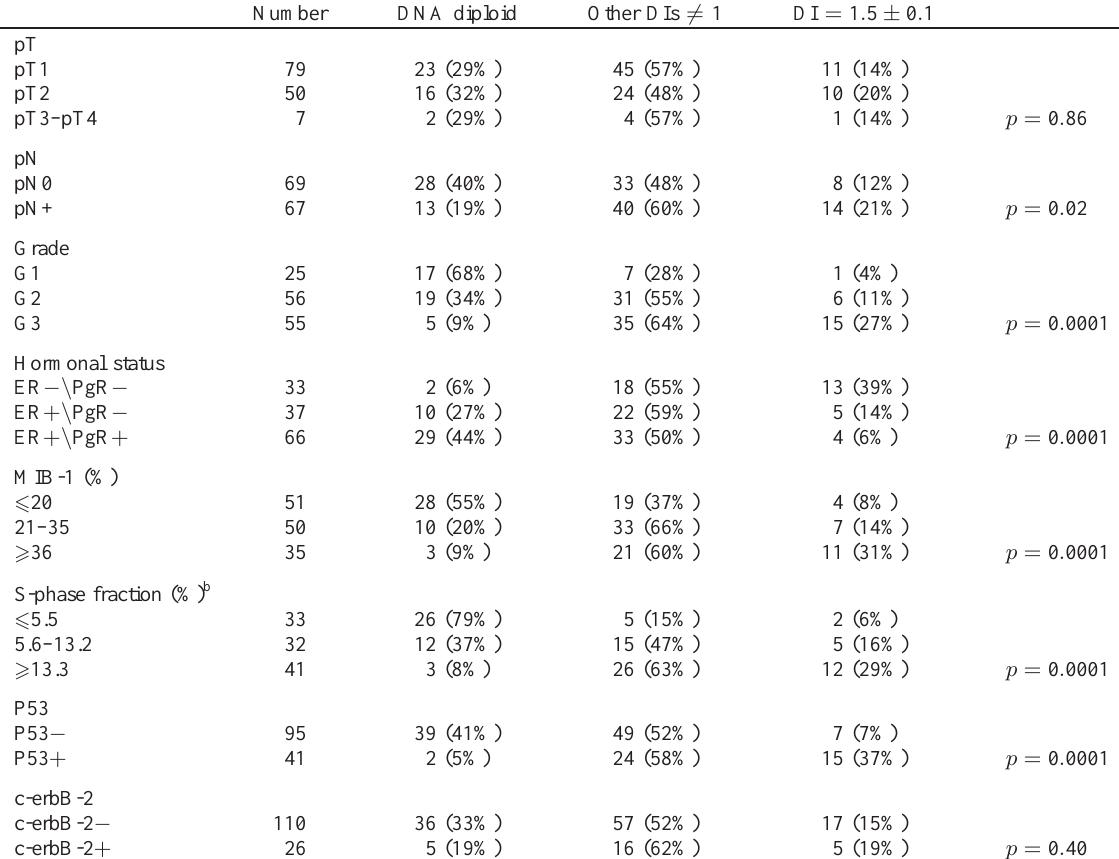
Table 3 Correlation of DI groups to clinico-morphologic and biologic parameters. Data merging subdividing classes in